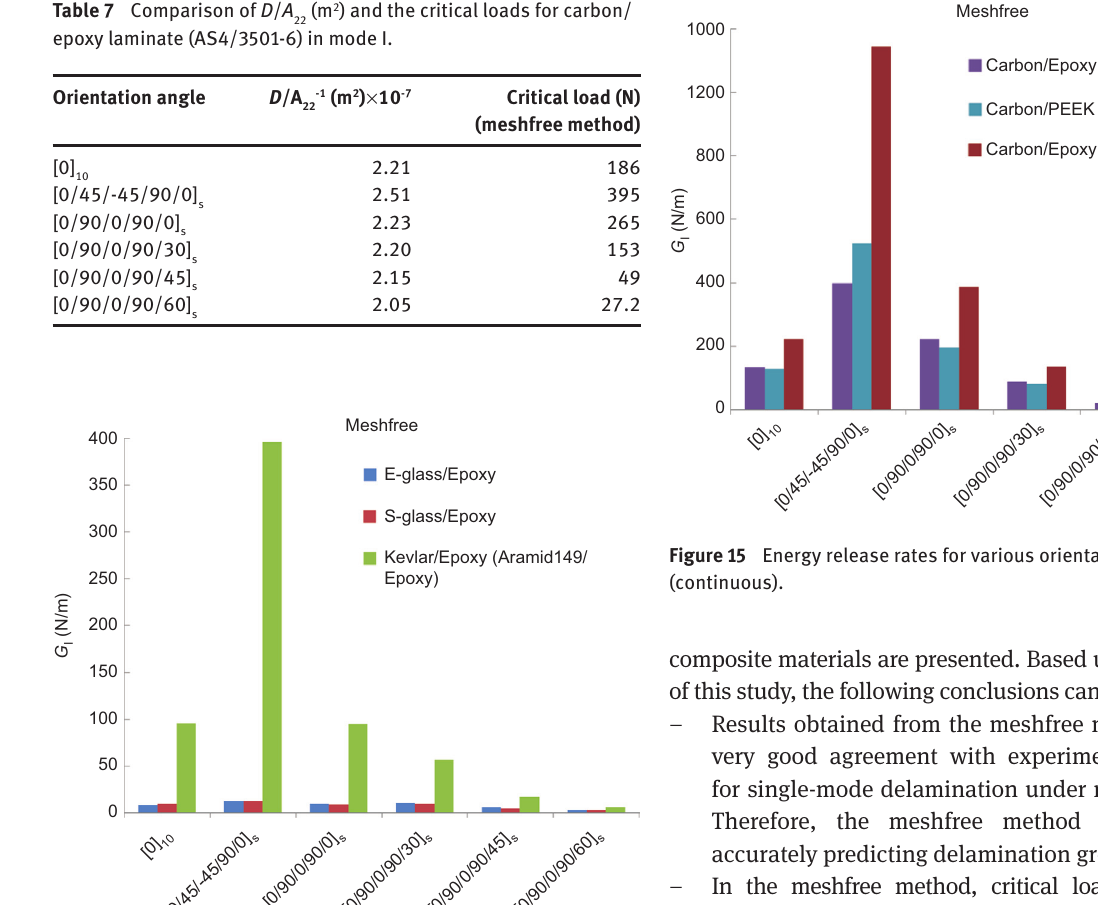
(m 2 ) and the critical loads for carbon/ 22